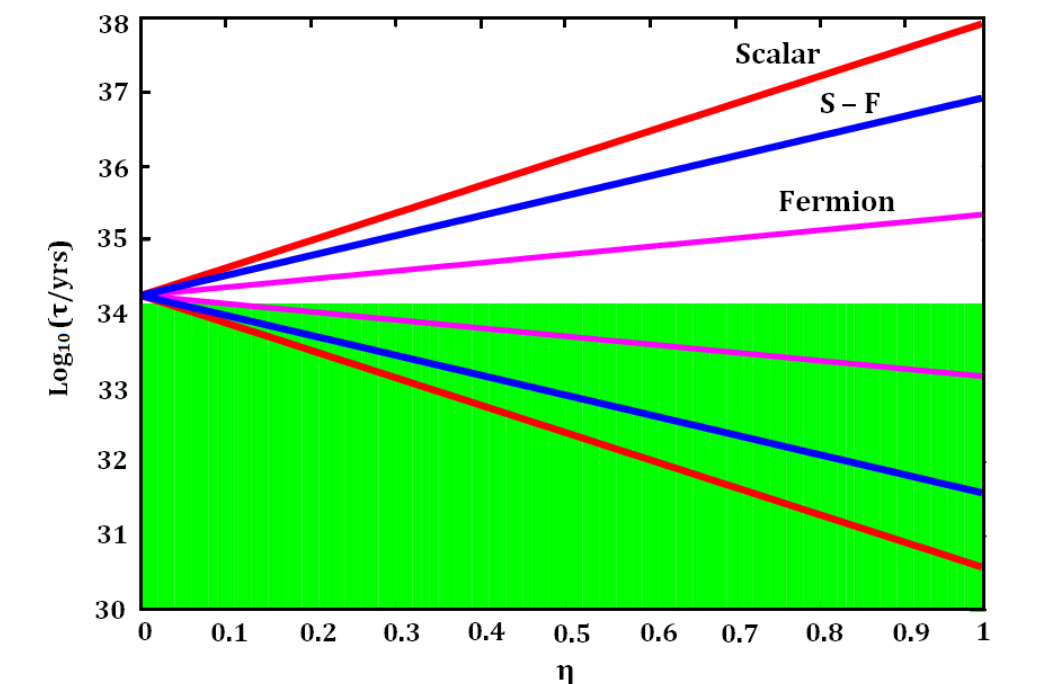
Figure 15 . Proton lifetime prediction for the decay mode p ! e + (cid:25) 0 shown by slanting solid lines as a function of (cid:17) = (cid:17) S ( (cid:17) F ) = j log ( M SH =M U ) j ( j log ( M F =M U ) j ) for super-heavy scalar(fermion) 10 10 components. The shaded green colored region is ruled out by the current experimental bound. The point at (cid:17) S = (cid:17) F = 0 represents the model prediction at two-loop level without threshold e(cid:11)ects with (cid:28) 0 = 1 : 8 (cid:2) 10 34 P